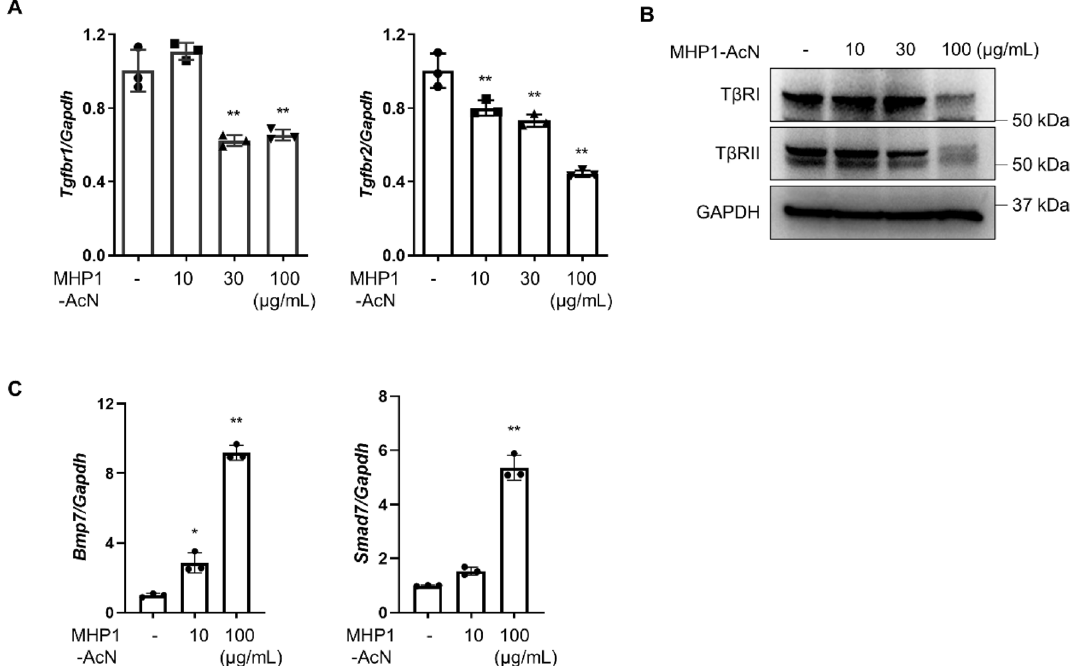
Figure 5. MHP1-AcN decreased TGF-β receptor expression via upregulating Bmp7 and Smad7 expression in fibroblasts. ( A ) qPCR results of Tgfbr1 and Tgfbr2 expression in MRC-5 cells after incubation with MHP1-AcN (10, 30 or 100 µg/mL) for 24 h. ** p < 0.01 vs Control. n = 3 in each group. ( B ) Western blot analysis of TβRI and TβRII levels in MRC-5 cells after incubation with MHP1-AcN (10, 30 or 100 µg/mL) for 24 h. The experiments were repeated at least twice. ( C ) qPCR results of Bmp7 and Smad7 expression in MRC-5 cells after incubation with MHP1-AcN (10 or 100 µg/mL) for 24 h. * p < 0.05, ** p < 0.01 vs Control. n = 3 in each